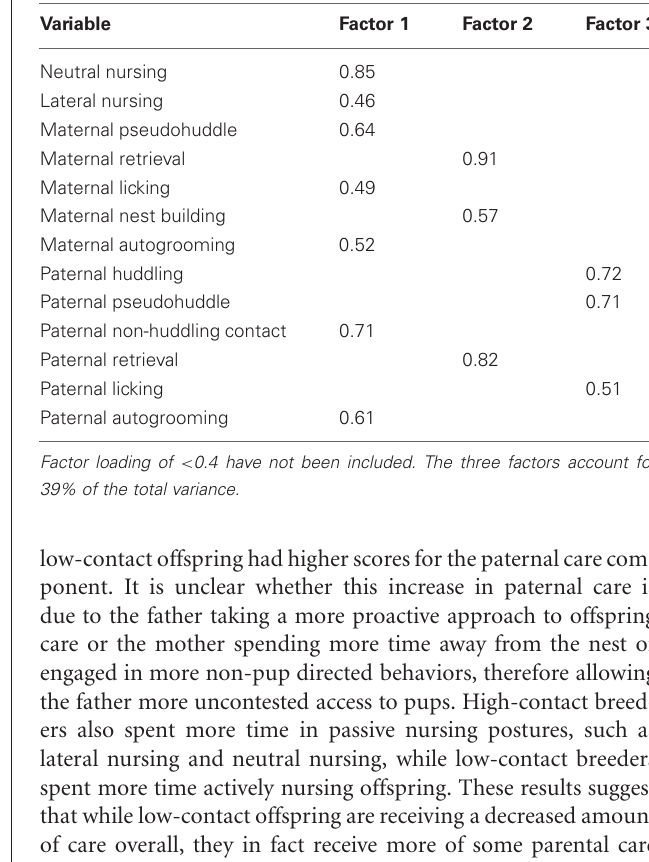
FIGURE 6 | Prepulse inhibition of tactile startle stimuli. (A) Low-contact offspring showed a greater potentiation of a tactile startle during tactile Trials 3 [ F ( 1 , 468 ) = 3 . 85, p = 0 . 05] and 5 [ F ( 1 , 468 ) = 6 . 45, p = 0 . 01] compared to high-contact offspring. (B) Low-contact males potentiated their startle response more than high-contact males during tactile Trial 5 [ F ( 1 , 468 ) = 4 . 57, p = 0 . 03] and low-contact females potentiated their startle response more than high-contact females during tactile Trial 5 [ F ( 1 , 468 ) = 4 . 05, p = 0 . 04]. ∗ p < 0 . 05, ∗∗ p = 0 . 01.